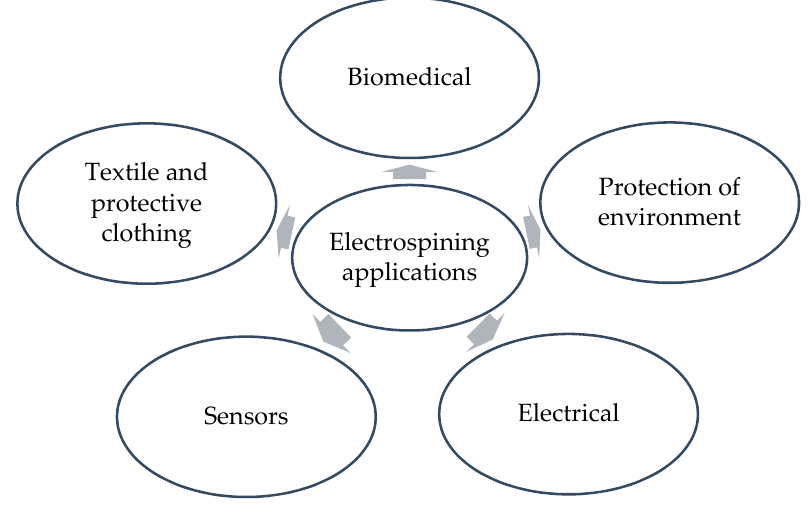
Figure 2. Electrospun nanofiber applications .